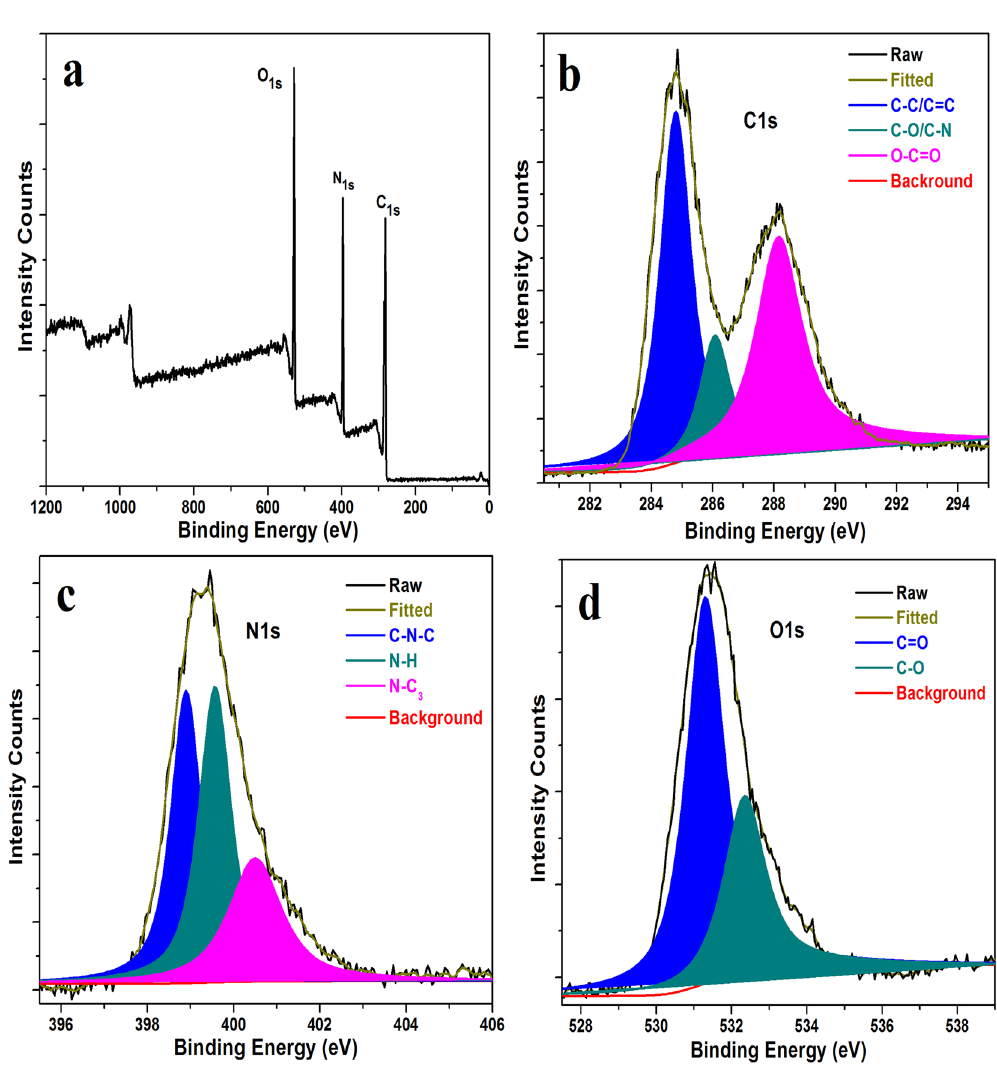
Figure 4. ( a ) Full XPS spectra of the obtained CDs. ( b – d ) High-resolution XPS spectra of the C 1 s, N 1 s and O1s of the obtained green-emitting CDs,